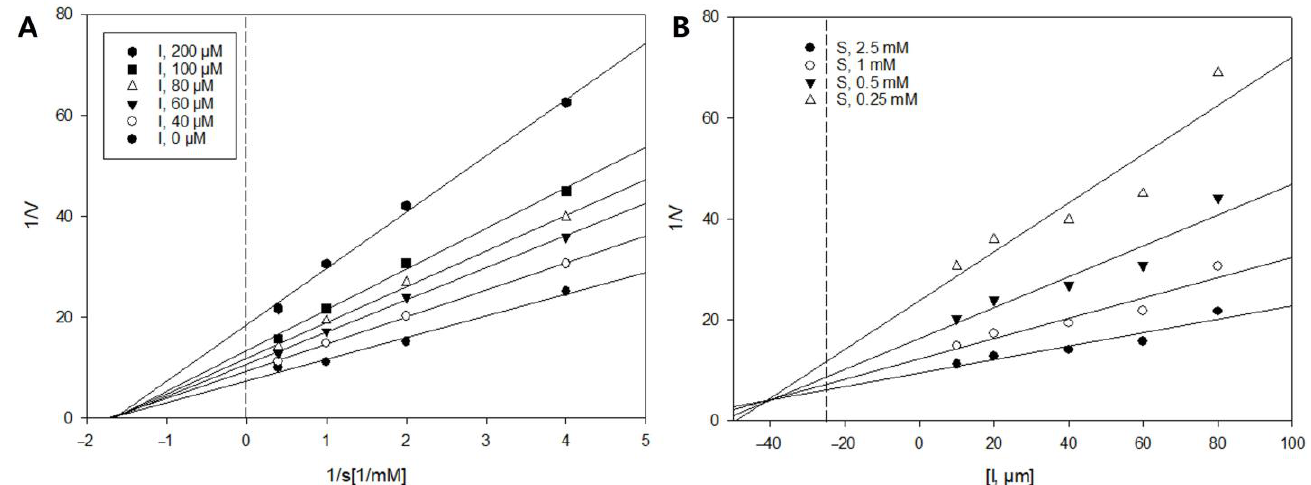
Figure 3. Lineweaver−Burk plot ( A ) and Dixon plot ( B ) analyses using active compound 1 .